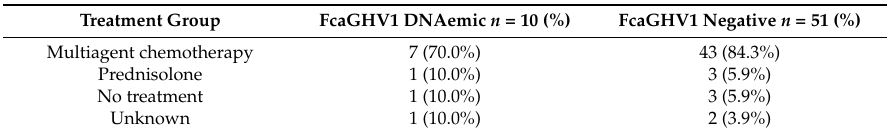
Table 3. Treatment status of FcaGHV1 positive and negative lymphoma cases with survival and treatment data